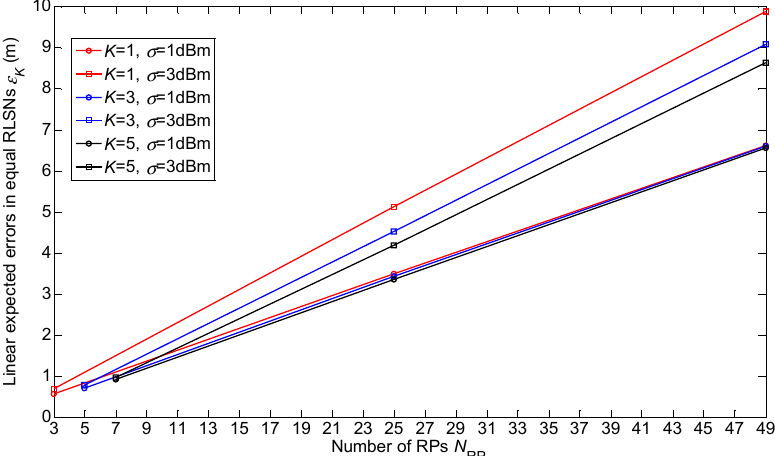
Figure 6. Linear expected errors with variations of K in equal-weighted RLSNs ( r = 0.5 m).